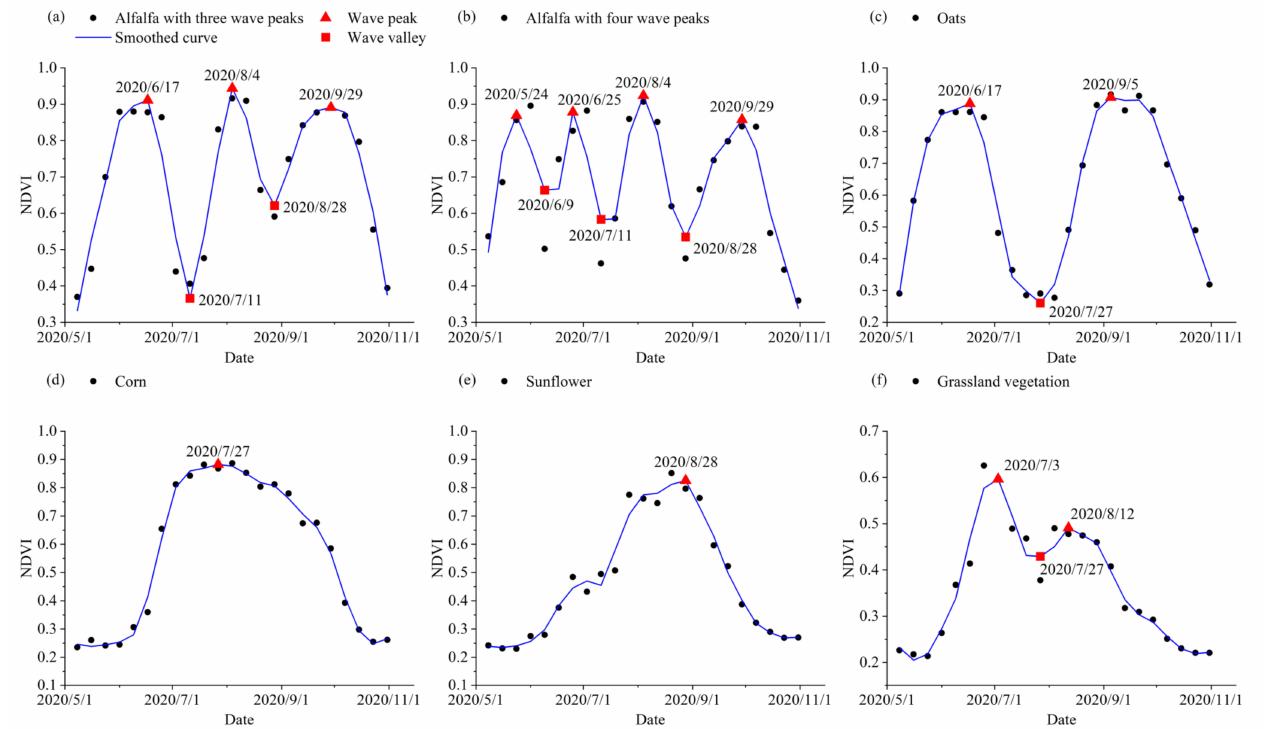
Figure 3. Smoothing, wave peak and valley identification characteristics of the NDVI series of different vegetation types derived from the MODIS